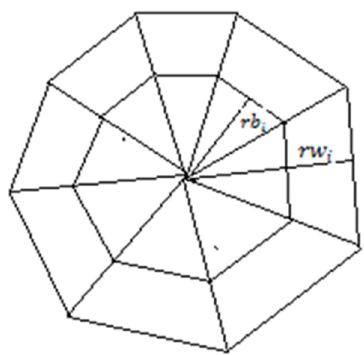
Figure 4. Two kernels centered in the same point. The inner kernel with the radius 𝑟𝑏 (cid:3036) is